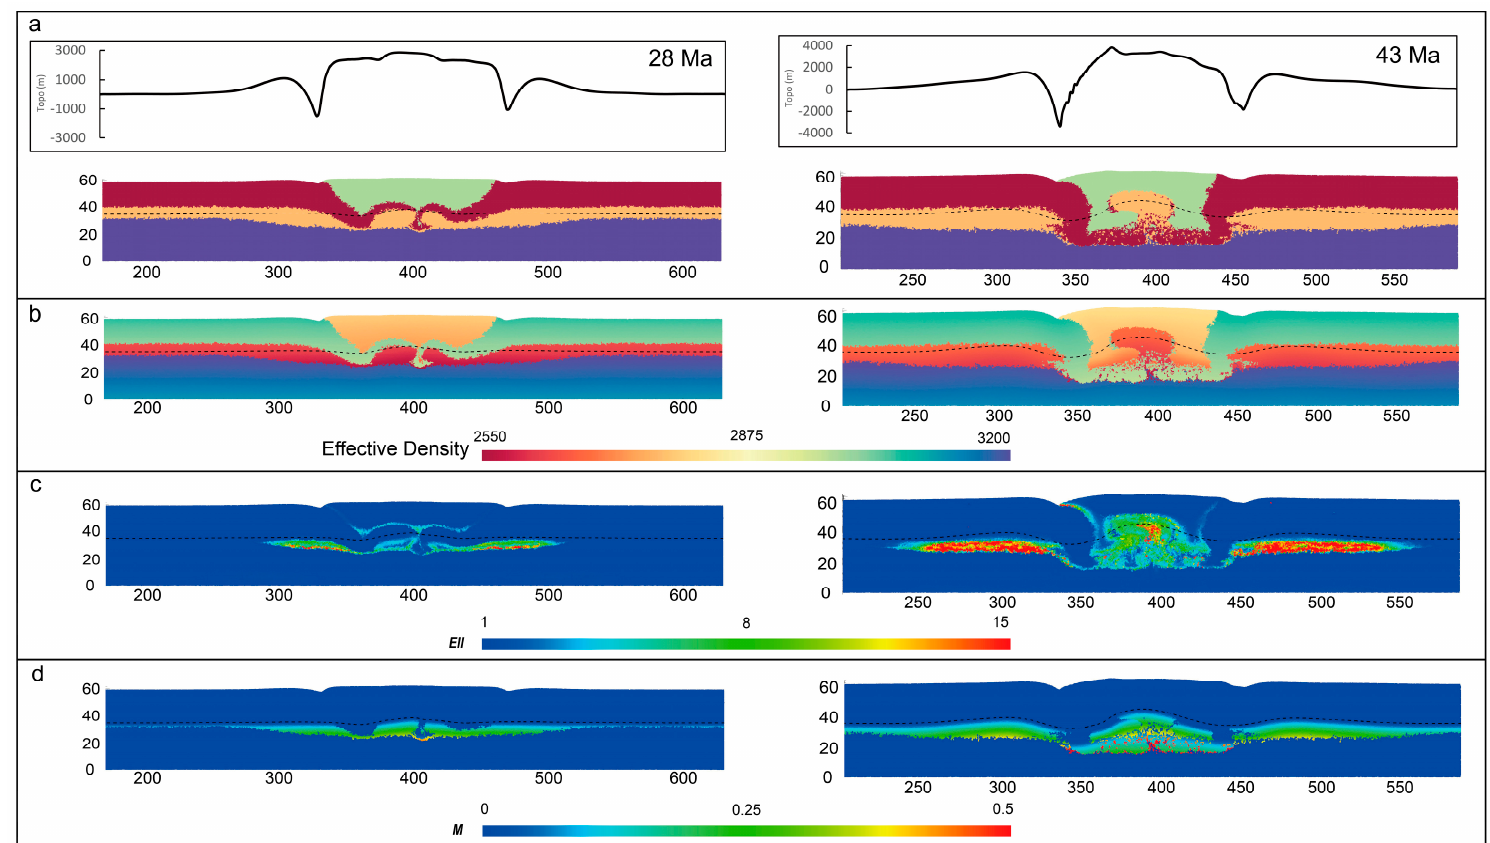
Figure 7. Model200 shows the evolution of folding-exhumation when the width of sediment is set to 200 km. The solidus temperature of the lower crust is shown in black dashed line. ( a ) At 28 Ma, buoyant lower crustal rocks start to form two crustal-scale folds and break through the mafic layer beneath the sediment (28 Ma). At about 43 Ma, partially molten lower crust rocks ascend into the sediment and form a diapir. Relief (Topo) is modelled using a free re-meshing surface boundary condition. The height of left side of the model is taken as 0 point to calculate uplift or subsidence. ( b ) Effective density is calculated by Equations (5) and (6). ( c ) The accumulation ( EII ) of the second invariant of the strain rate ( ε II , s − 1 ) is employed to identify shear zones over time (calculated by EII = ∑ t ∙ ∆ )). ( d ) Melt fraction is obtained by Equations (2) and (3).